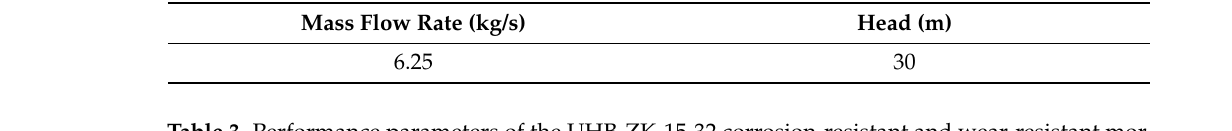
Table 3. Performance parameters of the UHB-ZK-15-32 corrosion-resistant and wear-resistant mor- tar pump.